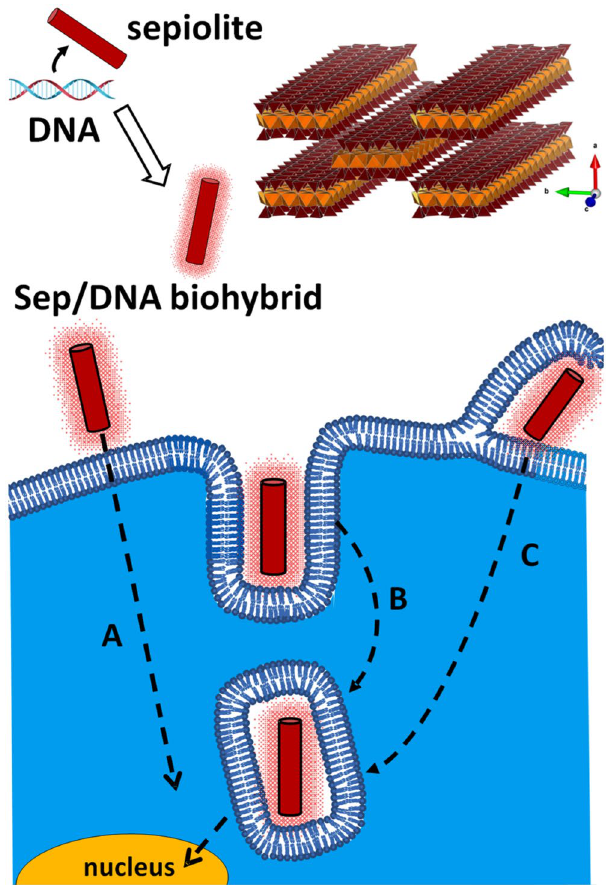
Figure 7. Scheme of sepiolite-mediated DNA delivery into mammalian cells. DNA interacts with sepiolite then the Sep/DNA biohybrids interacts with mammalian cells. The Sep/DNA complex can be internalized into cells either directly ( A ), or via endocytosis through invagination of the cell membrane ( B ), or via macropinocytosis with pseudopods ( C ). These last processes result in embedded Sep/DNA complex into the cytoplasm. In some occasion direct internalization of Sep/DNA result in unembedded complex. After spontaneous release, the DNA is imported to the nucleus leading to its stable integration into the cell